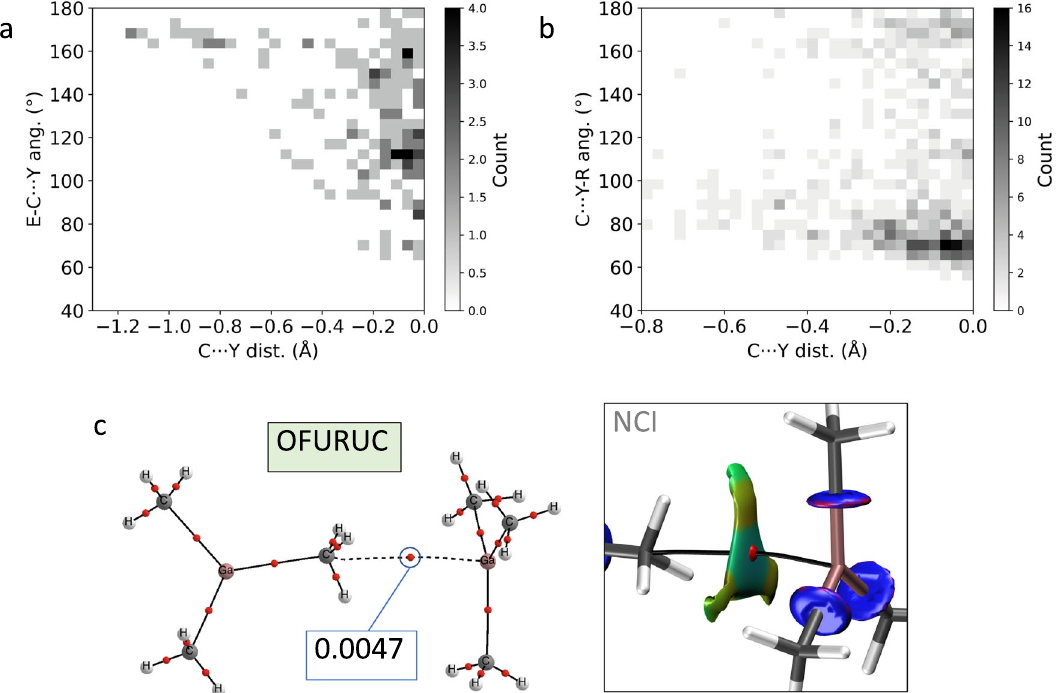
Fig. 5 Triel bonding. a E-C···Y and b C···Y-R angles distribution as a function of the C···Y vdW-normalized distance for Y = Al, Ga, In, and Tl. E can be any group 13, 14 (except C), and 15 (except N) atom. Source data are provided as a Source Data fi le. c QTAIM and NCI graphs showing the methyl···gallium interaction in the crystal structure of OFURUC. The values of the electron density at the BCPs are given in a.